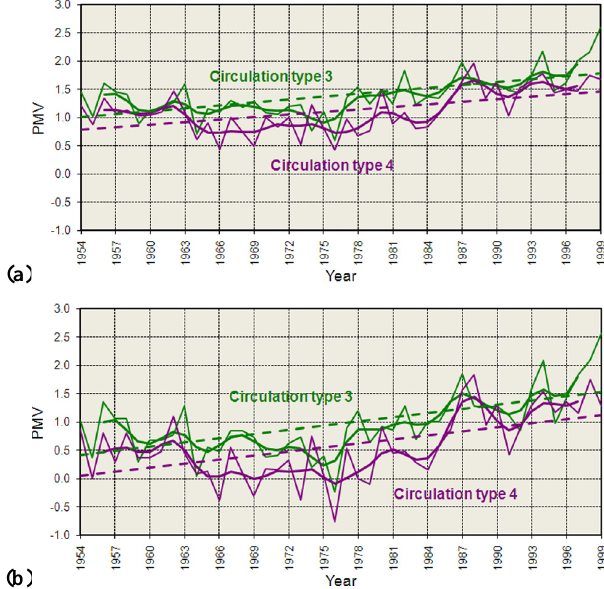
Fig. 9. As in Fig. 1 but for circulation types 3 and 4 and for the period 1954–1999.